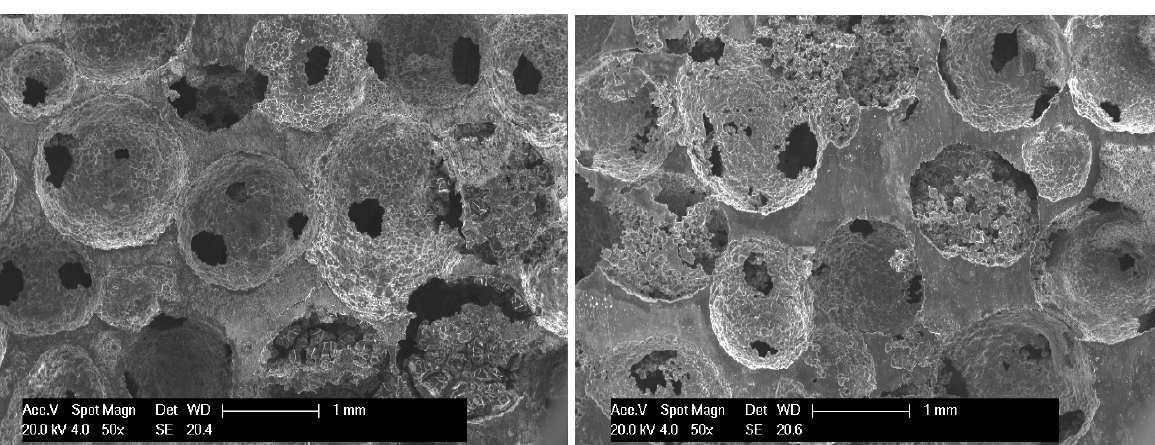
Figure 9. SEM images of foams made by infiltration of salt bead preforms compacted at 32 MPa, (left) at 14 psi and (right) at 36 psi.